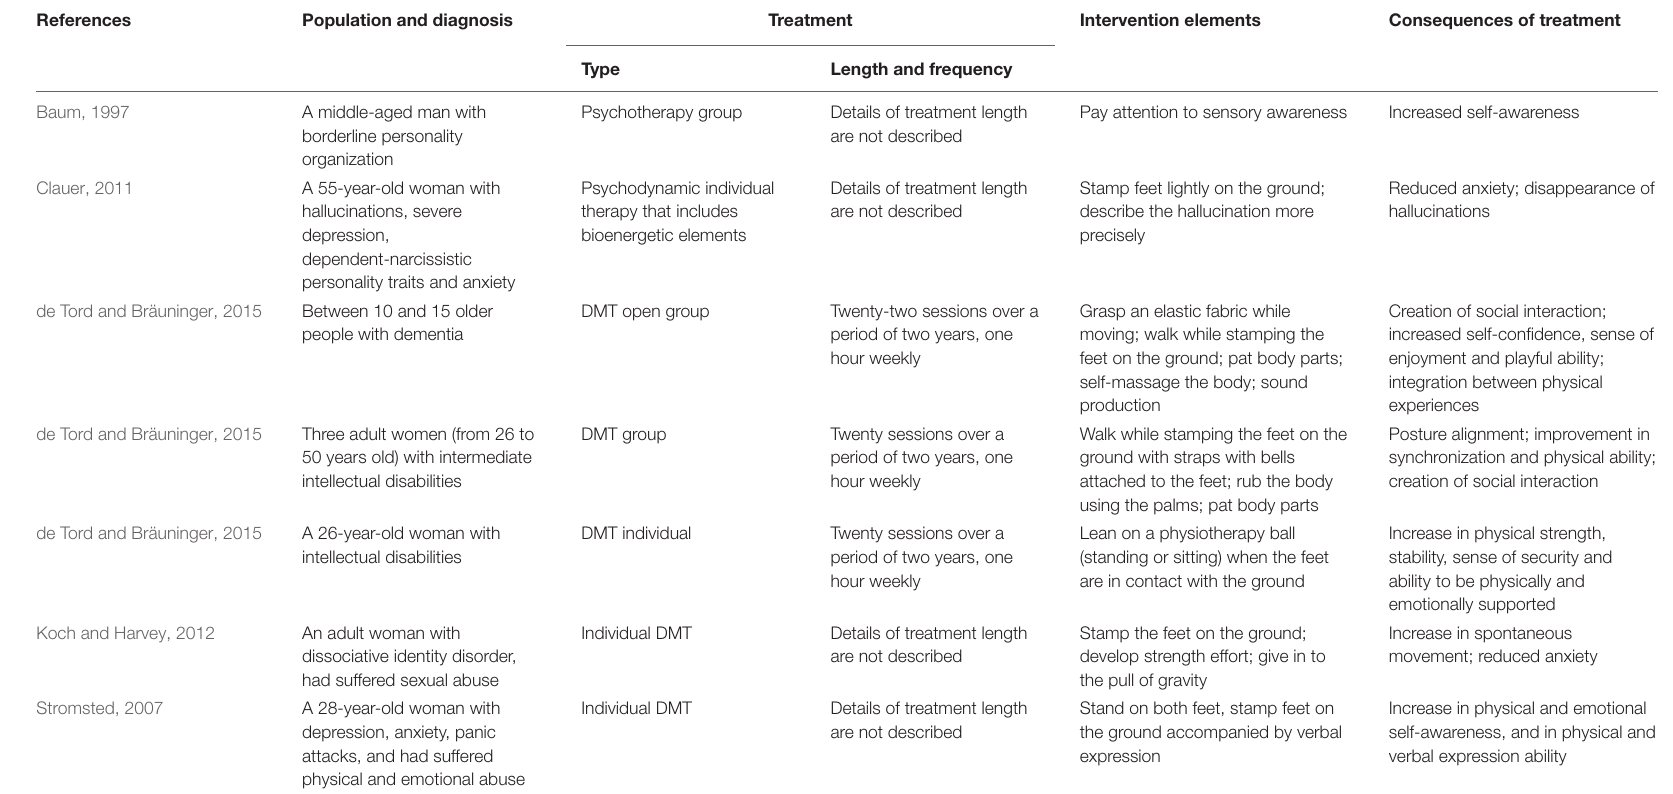
TABLE 1 | Clinical Descriptions of Grounding